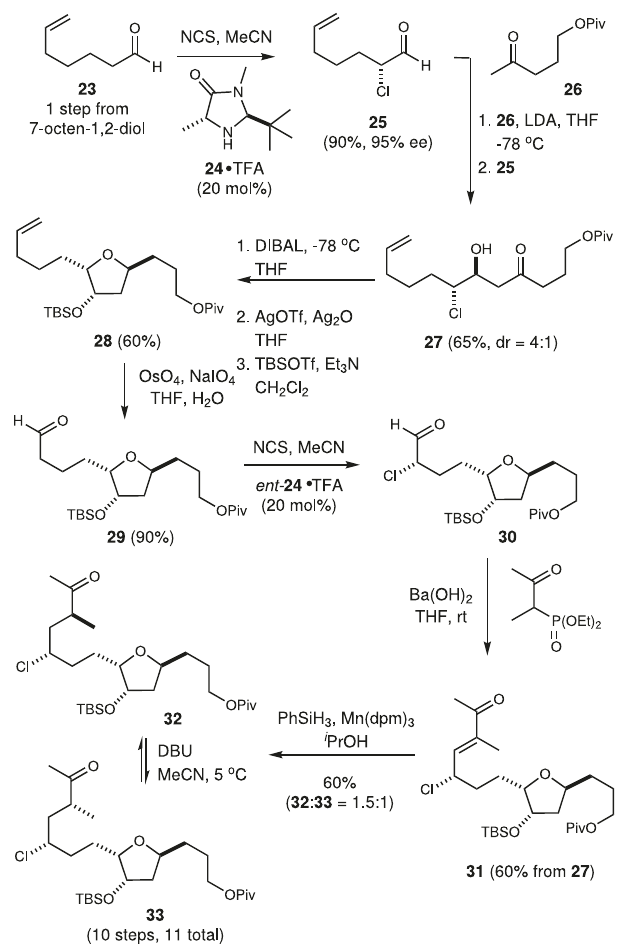
Fig. 3 | Synthesis ofthe C14 – C26 methyl ketone 33. Two separate asymmetric α - chlorination reactions are employed in the synthesis of the chloroketone 33 required for the key Corey – Chaykovsky coupling. LDA lithium diisopropyl